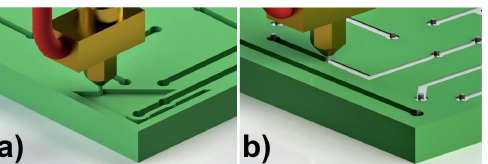
Figure 1. Schematic illustration of an additive process for fabricating 3D-printed structural circuits from fusible alloys. ( a ) Preparation of a polymer substrate with the standard FDM printing process using thermoplastic polymers or composites. ( b ) Fabrication of conductive metallic paths from fusible alloys with a modified FDM technique adapted for low-temperature metals and alloys (FDMm).